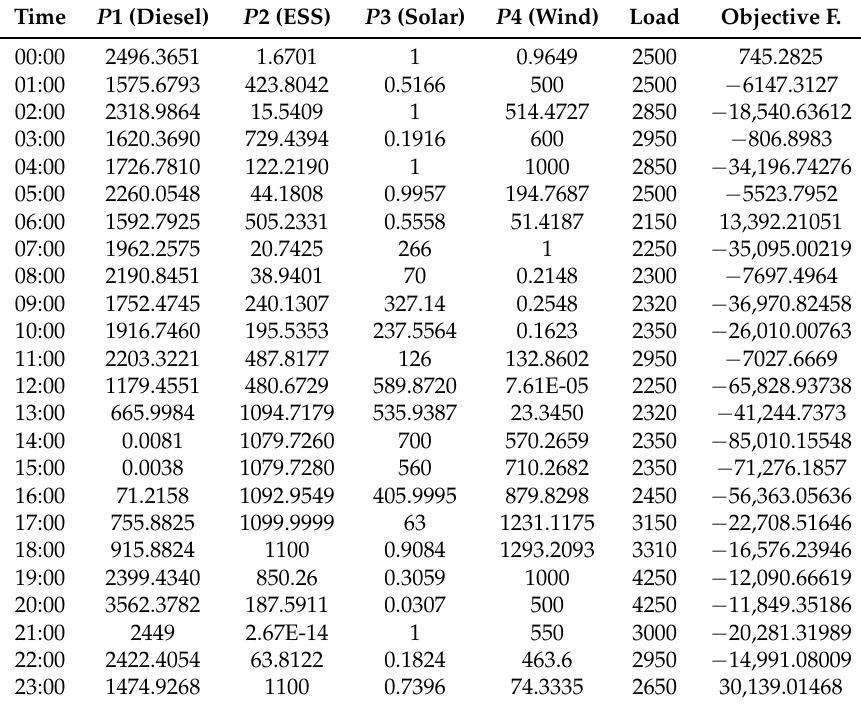
Table 7. Details of the best solution found by the TS-MBFOA.